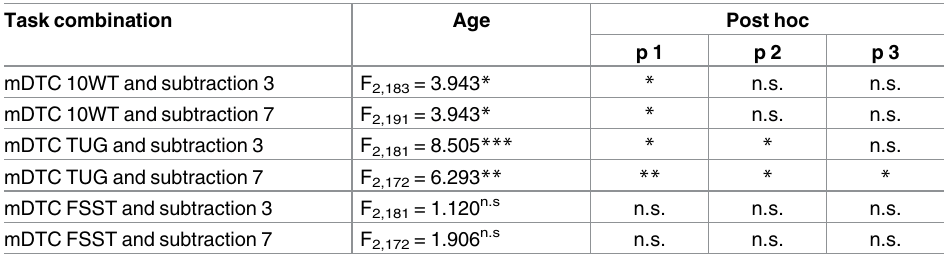
Table 3. ANCOVAs and post hoc results for the